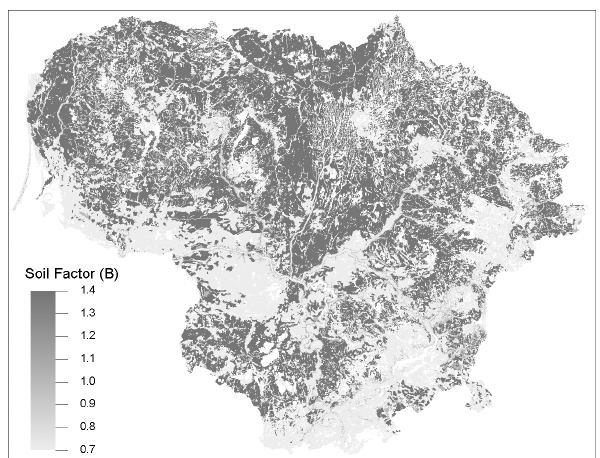
Fig 6 . Land cover factor